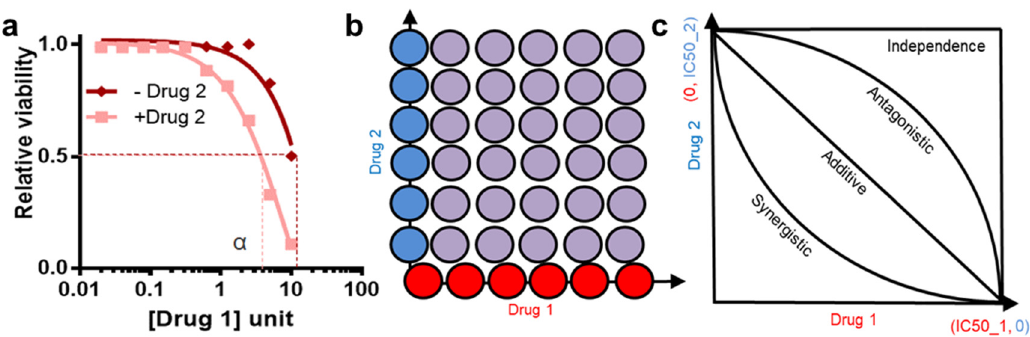
Figure 6. Drug synergy measurement methods. ( a ) Synergy measured by visualizing left-shifting of dose response curve of Drug 1 in presence of the Drug 2. ( b ) Cartoon illustrating comprehensive checkerboard- style experimental setup where combinatorial doses are marked as purple and only Drug 1 as red and only Drug 2 as blue. ( c ) Isobologram analysis indicates multiple possible outcomes for drug interaction analysis- for additivity diagonal, independence rectangular, for synergy concave and for antagonistic convex